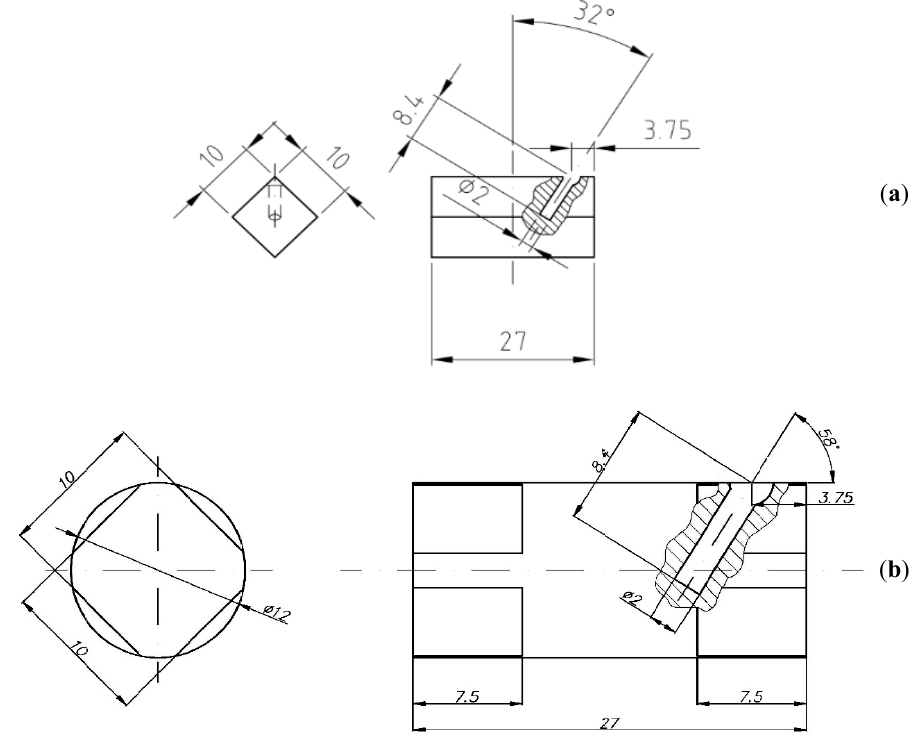
Figure 18. Samples prepared for the deformation process in the MaxStrain device: ( a )—a sample with a square cross-section of 10 × 10 mm; ( b )—a sample with a circular cross-section of 12 mm in diameter.